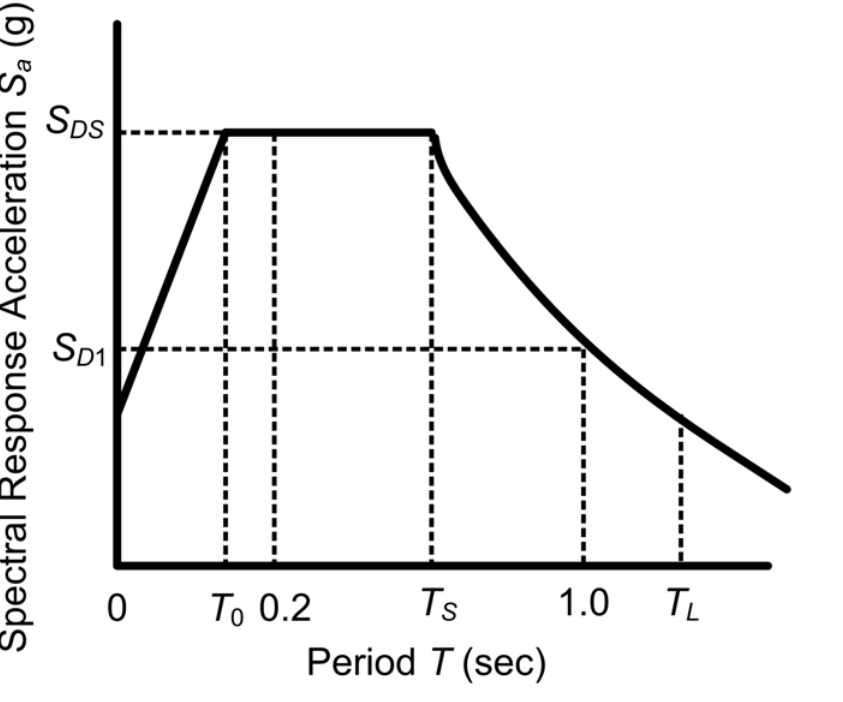
Fig 2. Design response spectrums.